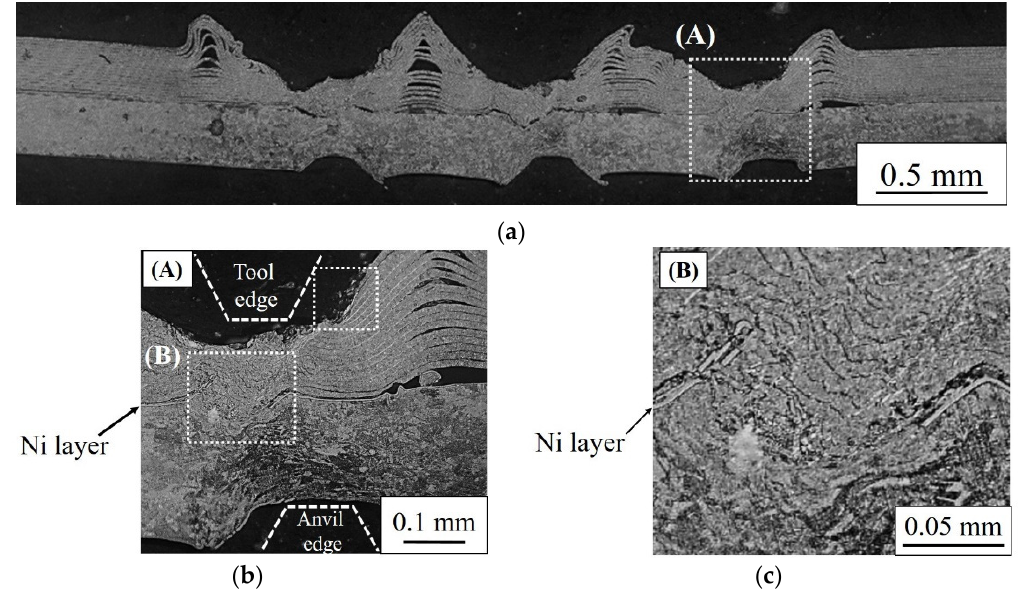
Figure 12. Optical micrographs of cross sections when using the K-type tool: ( a ) entire bonded region, ( b ) magnified version of (A) and ( c ) highly magnified version of (B).